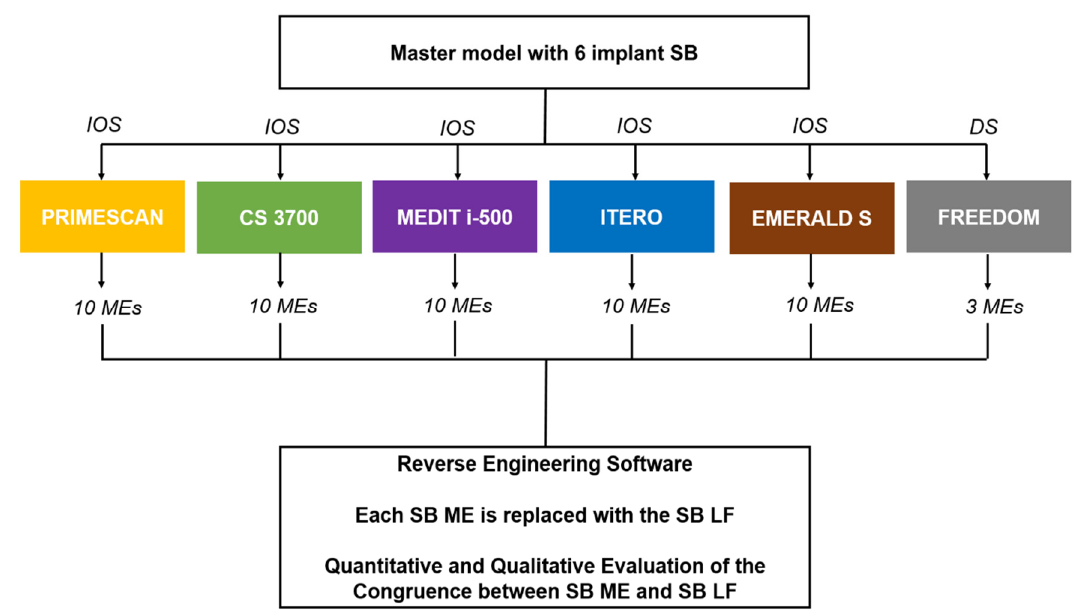
Figure 1. Schematic drawing of the design of the study.